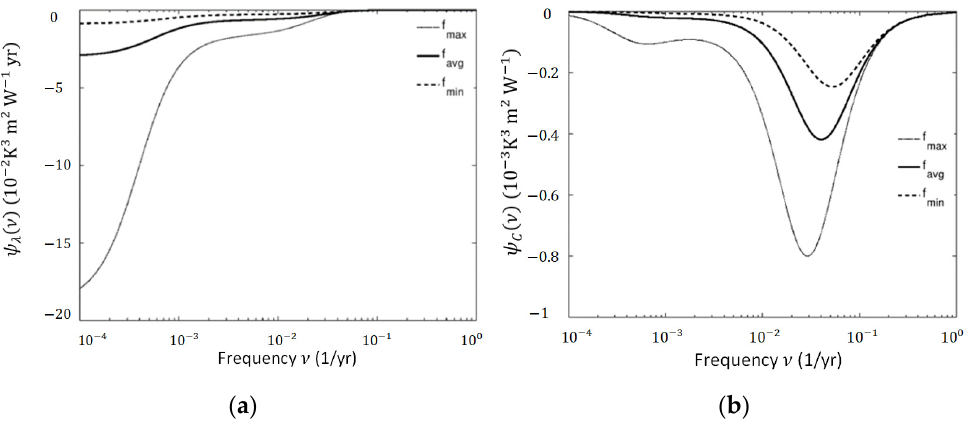
Figure 3. Absolute sensitivity functions ψ λ ( a ) and ψ C ( b ), which were calculated for different values of the feedback coefficient f .